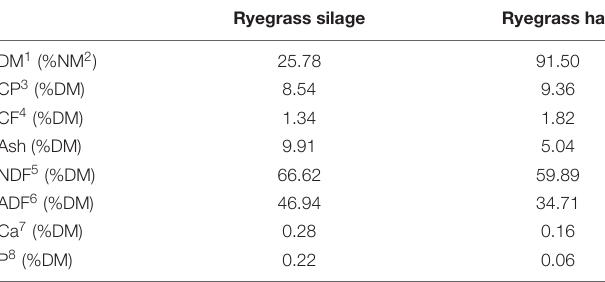
TABLE 1 | Nutritional composition: ryegrass silage, hay (As fed). Ryegrass